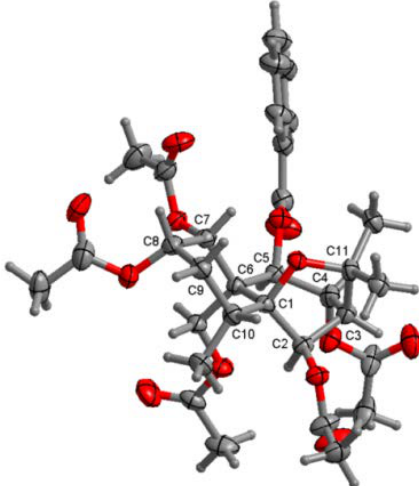
Figure 2. X-ray ORTEP drawing of compound 1